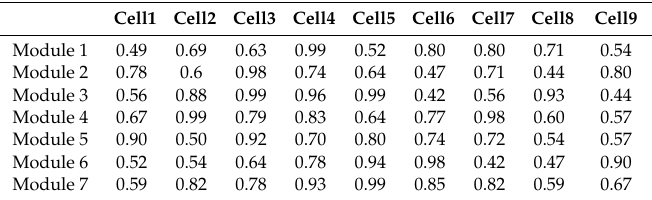
Table A1. Initial SoC of cells in the LiBP at 25 ◦ C (The SoC from 0% to 100% expressed as range from 0 to 1).